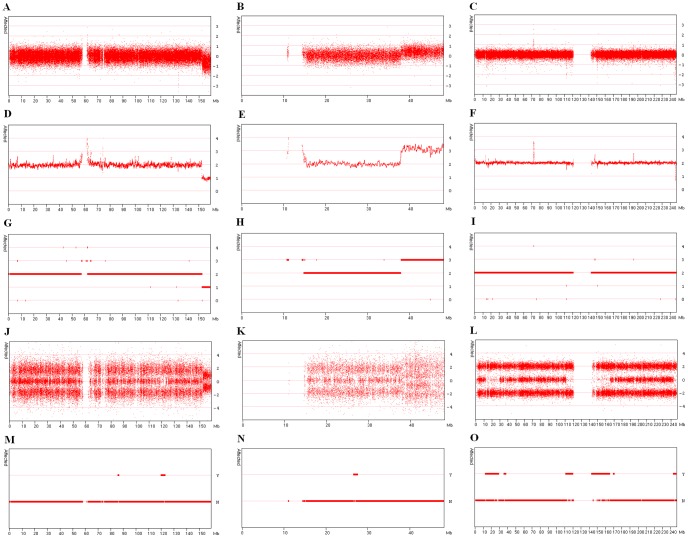
Visualisation of chromosomes containing a large deletion, duplication or autozygous segments.
Figures 3A, 3D, 3G, 3J and 3M contain a deleted region on the p arm of chromosome 7 in Patient One. Similarly, Figures 3B, 3E, 3H, 3K and 3N display the data for a duplication on the p arm of chromosome 21 in Patient One. While Figures 3C, 3F, 3I, 3L and 3O show the presence of autozygous regions on chromosome 1 of a consanguineous individual. Regions of copy number variation can be seen as a series of Log2 values that do not tend to zero (Figures 3A, 3B and 3C). These values are then used to create the Smooth signal data (Figures 3D, 3E and 3F). Finally, the CN state for each probe is determined and shown as an integer value between 0 and 4 (Figures 3G, 3H and 3I). The genotype of each SNP probe is shown in the Allele difference dataset, which typically contains three clusters of values representing the ‘AA’, ‘AB’ and ‘BB’ genotypes. Deletions can be seen where data points form just two distinct clusters representing the A- and B- haploid genotypes (Figure 3J), while duplications are seen as four clusters of data points representing the AAA, AAB, ABB and BBB triploid genotypes (Figure 3K). Autozygous regions can be determined by the absence of the central heterozygous cluster (Figure 3L). LOH data points have a value of ‘Y’es or ‘N’o, with duplicated or deleted regions scoring N while autozygous regions or typically scored as Y.